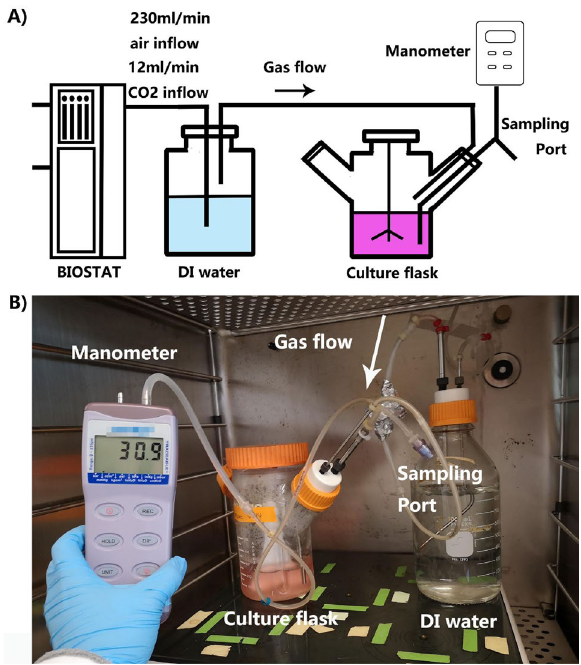
Figure 1. Experimental device design. ( A ) Schematic of pressurized CHO culture system. ( B ) Photo of actual setup in a standard CO 2